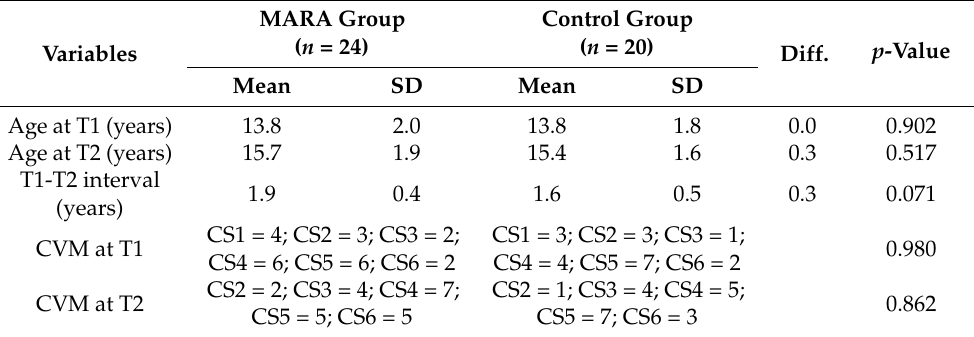
Table 1. Demographics with statistical comparisons (independent-samples t -tests or Mann–Whitney U test or chi-square